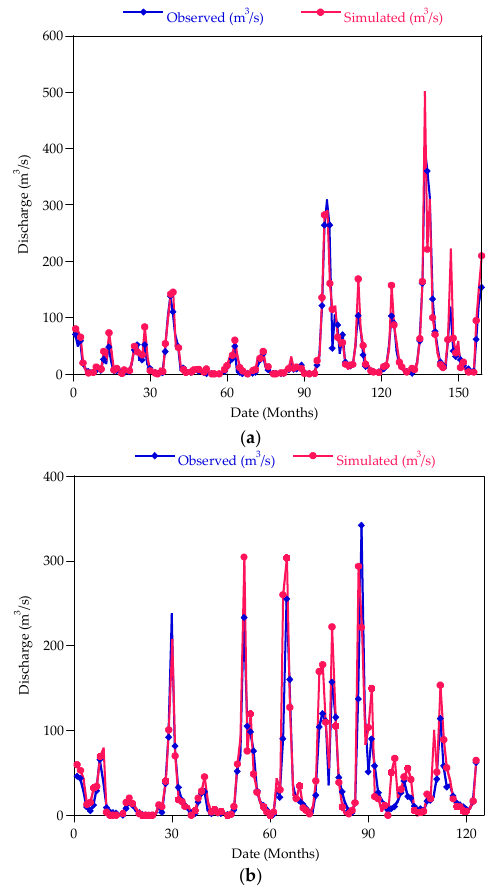
Figure 3. Observed and simulated monthly streamflow for ( a ) calibration and ( b ) validation periods. Table 5. Monthly time step calibration and validation performance statistics.